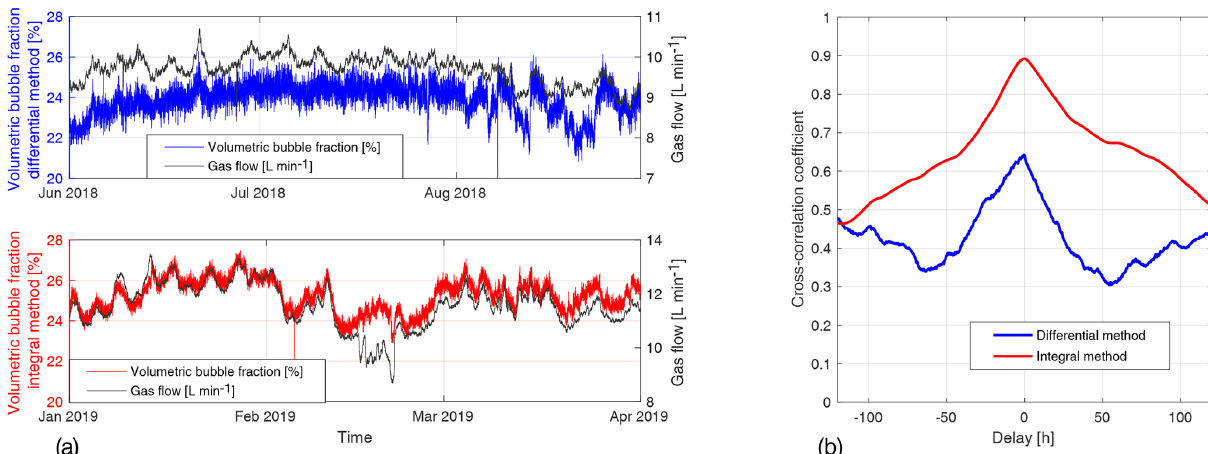
Figure 6. (a) Comparison of volumetric bubble fraction derived using differential (top) and integral (bottom) methods with the gas flow at the Hartoušov F1 borehole. Depth of pressure probes for the differential method are 4.45 and 5.45m below the surface. For the integral method it is 5.45 and 27.2m. In (b) the cross-correlation functions between the bubble fraction and gas flow rate are